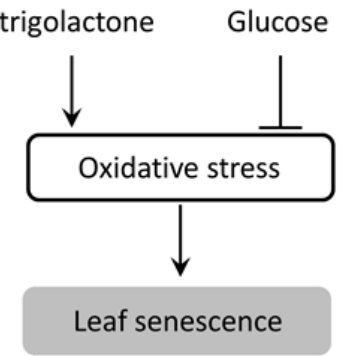
Figure 7. Proposed model of effect of SL and glucose on leaf senescence in darkness in this study.